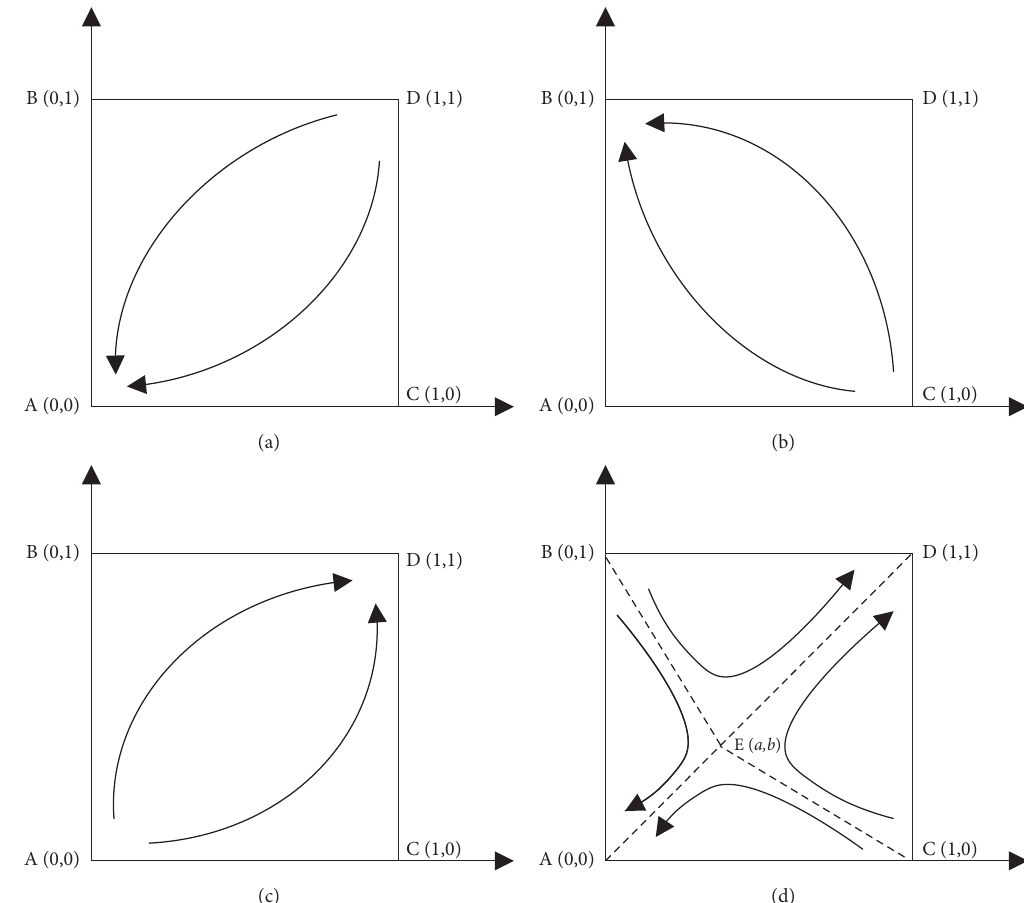
Figure 1: System evolution steady state phase diagram. (a) Evolutionary stable state is (nonparticipation, nonparticipation). (b) Evo- lutionary stable state is (nonparticipation, participation). (c) Evolutionary stable state is (participation, participation). (d) Multiple evolutionary stable